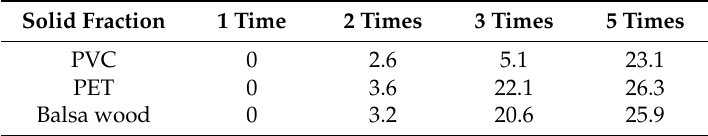
Table 4. Pressure (>100 Pa) area radius reduction (%) with